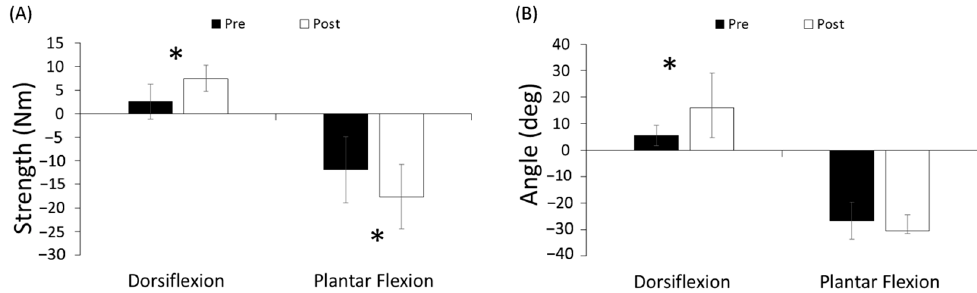
Figure 4. Biomechanical outcome amounts at pre- and post-training. ( A ) shows the strength of dorsiflexor and plantar flexor and ( B ) gives the active range of motion in dorsiflexion and plantar flexion of trained ankles among children with CP. (*) indicates significant difference ( p <